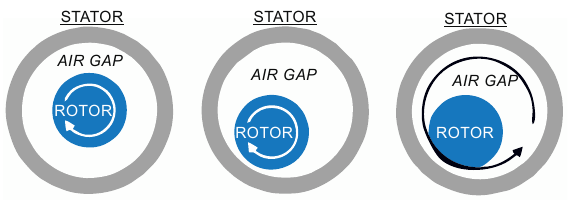
Figure 1. Healthy motor ( left ), static eccentricity fault ( center ), and dynamic eccentricity ( right ). Eccentricity is related to air gap distortion. When a mixed eccentricity fault occurs,